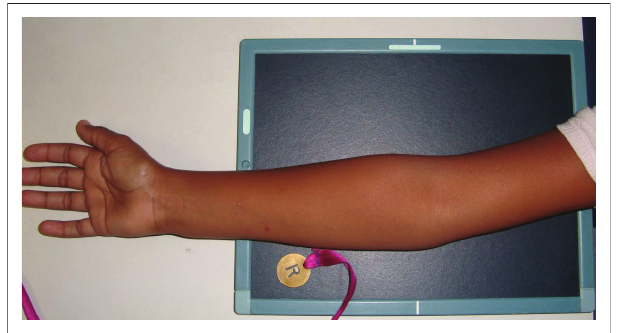
FIGURE 1: Positioning for the anteroposterior (AP) projection. The elbow should be in contact with and in the middle of the cassette in full extension with the forearm supinated.